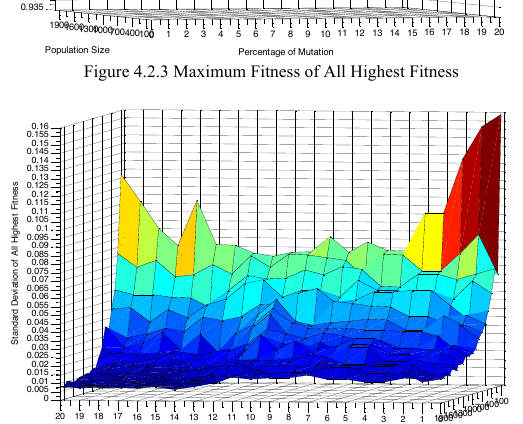
Figure 4.3.3 Maximum Fitness of All Highest Fitness